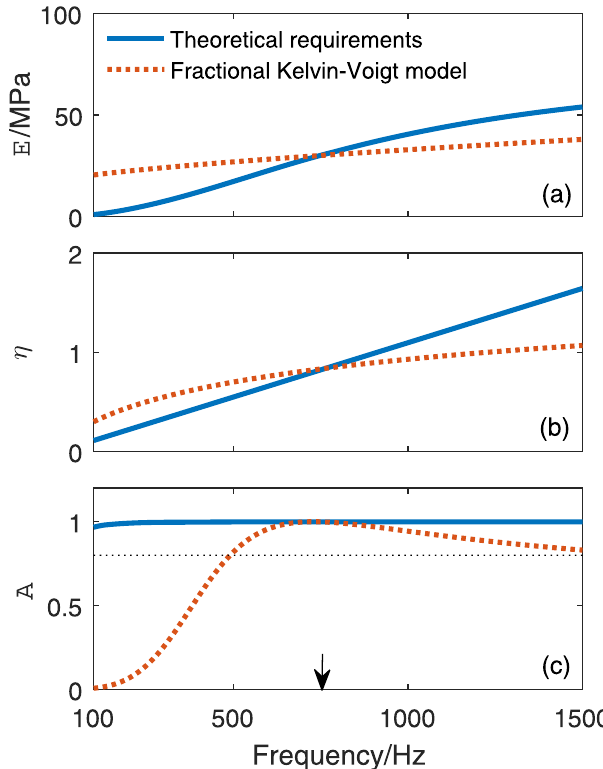
Figure 6. The frequency-dependent ( a ) dynamic modulus E and ( b ) loss factor η of the Young’s modulus of rubber matrix and ( c ) the corresponding sound absorption of the cavity-based metasurface (designed at f p = 750 Hz). The black dotted horizontal line in ( c ) stands for the 80% of absorption. The black arrow points out the frequency position of perfect